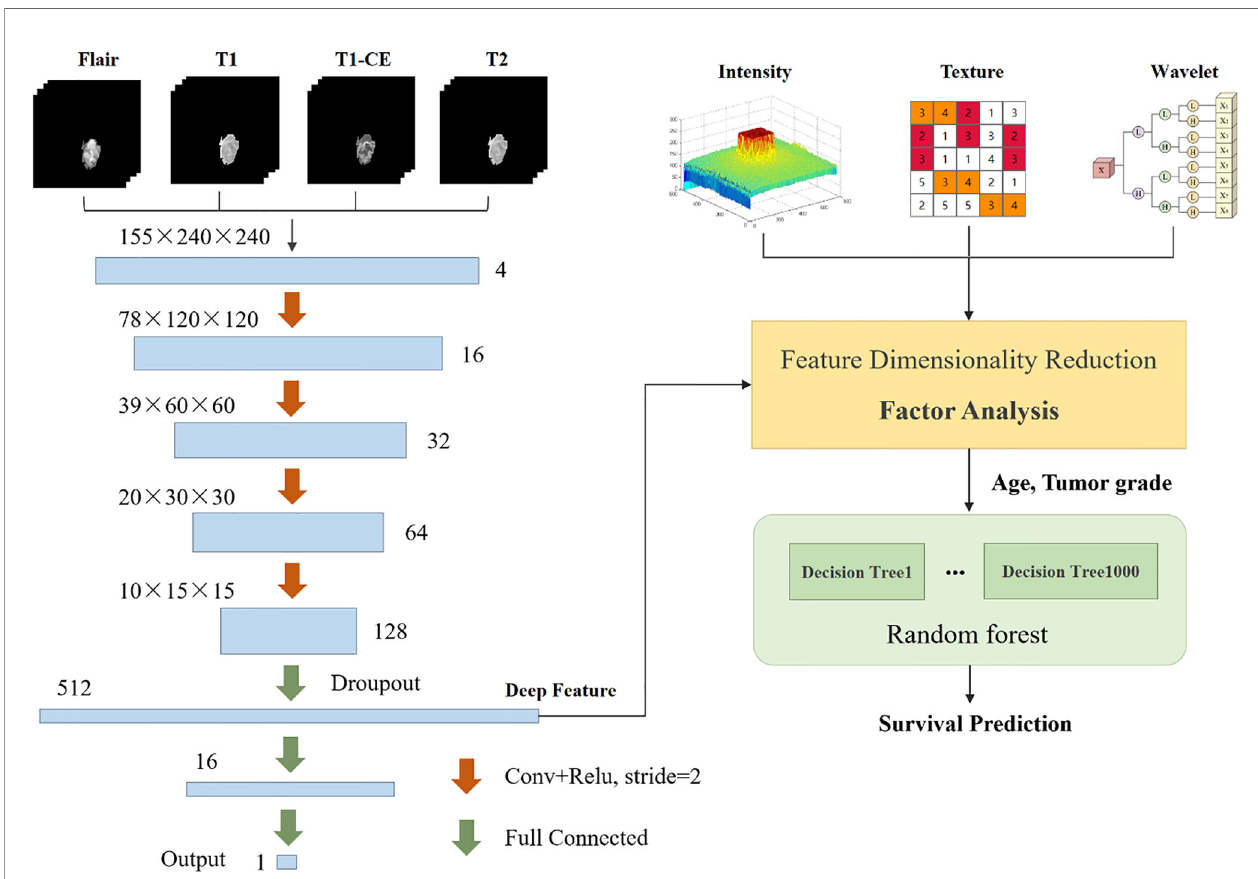
FIGURE 6 | Summary of prediction methods for the survival period of patients with brain tumors.